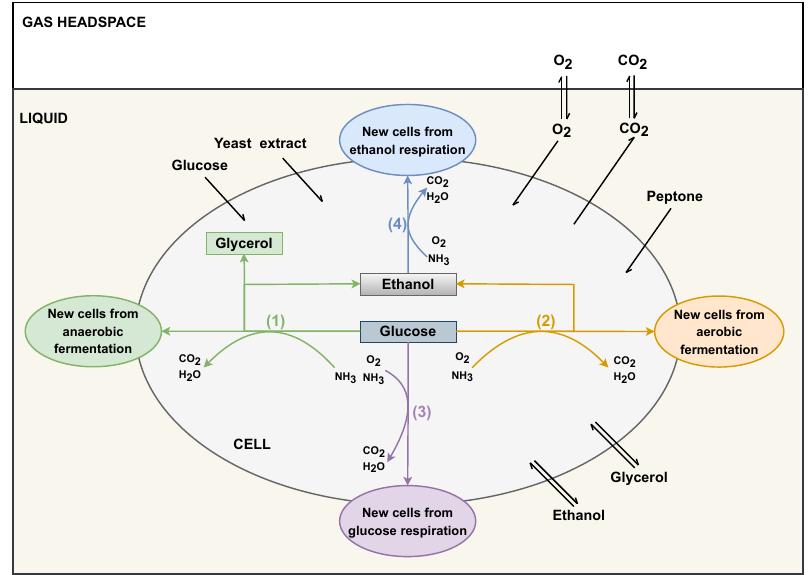
Figure 2. Metabolic pathways of Saccharomyces cerevisiae considering the Crabtree effect. (1) Anaerobic fermentation. (2) Aerobic fermentation (glucose concentration > 0.10–0.15 g/L). (3) Respiration based on glucose (glucose concentration < 0.10–0.15 g/L). (4) Respiration based on ethanol.